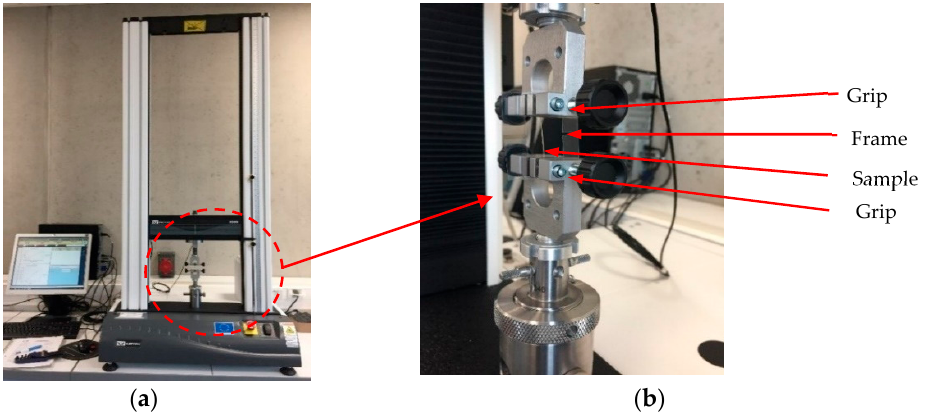
Figure 4. Setup of the tensile test according to ASTM C1557: ( a ) INSTRON 3369 universal testing machine; ( b ) details of grips and specimen.